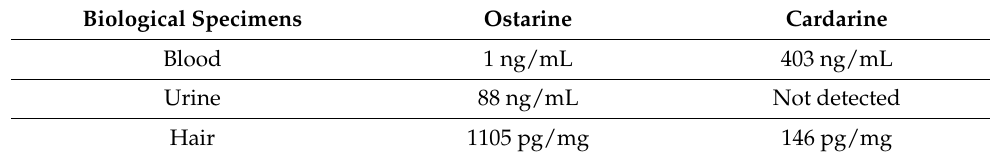
Table 3. Measured concentrations in biological specimens from the admission.